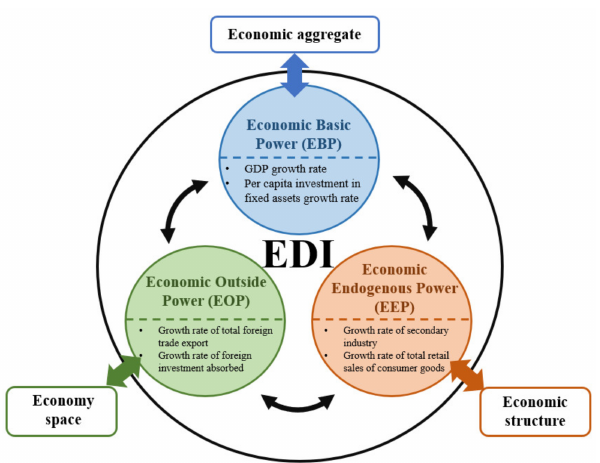
Figure 3. The EDI Frame of Beijing–Tianjin–Hebei Urban Agglomeration.